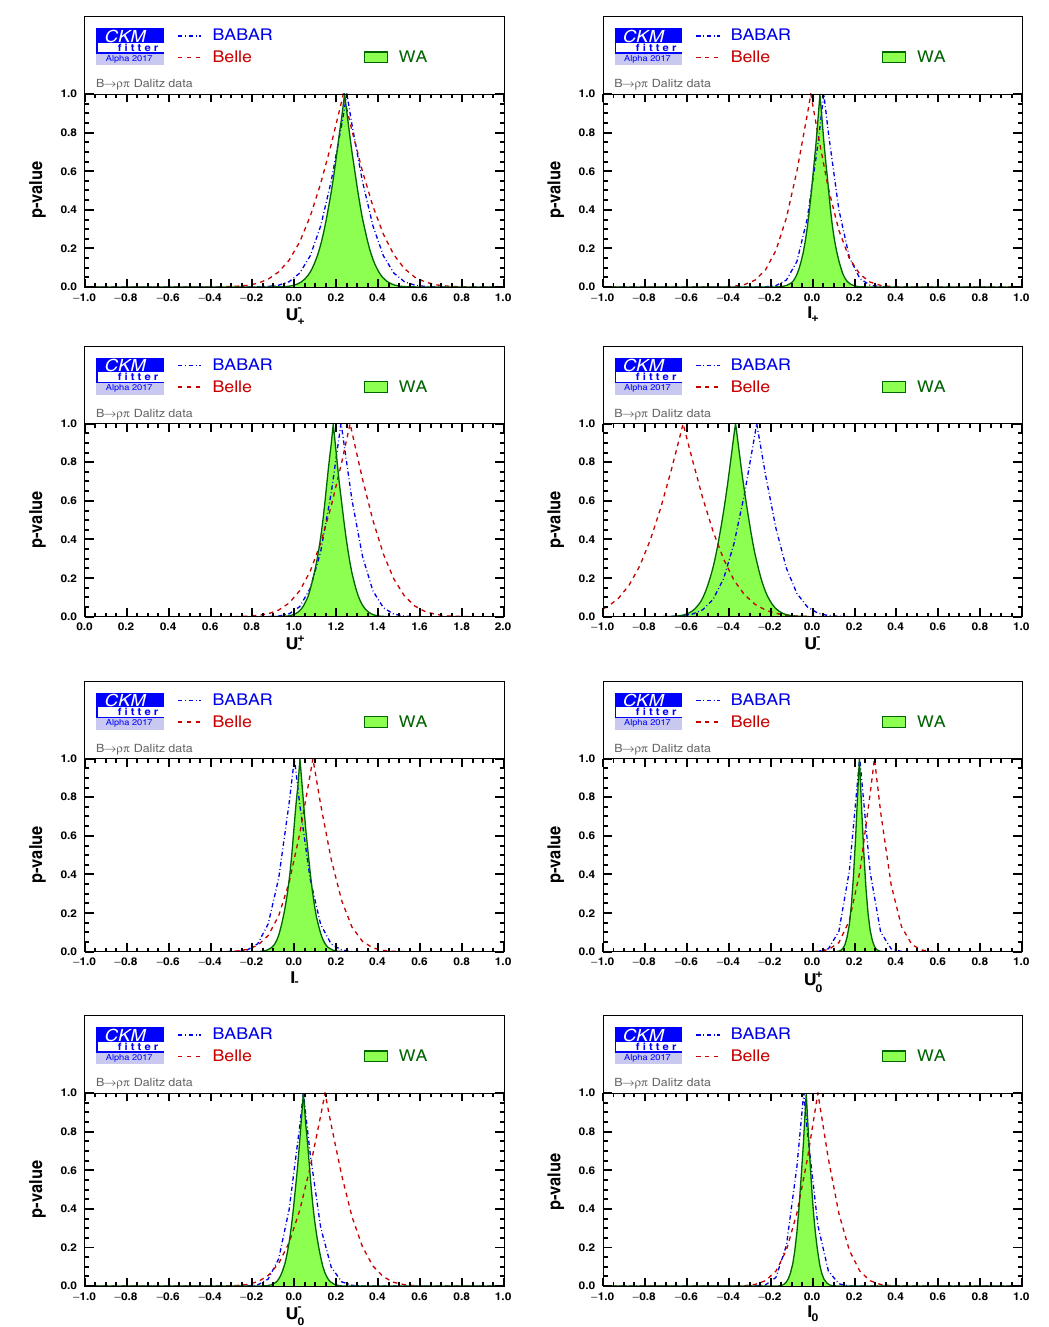
Fig. 48 Experimental measurements of the Q2B-related U and I parameters from BaBar ( blue curve ) and Belle ( red curve ). The green shaded area represents the world